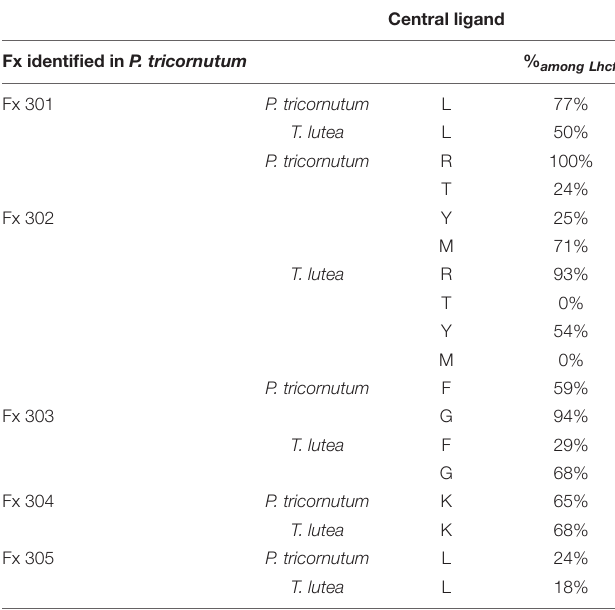
TABLE 3 | Binding sites of Fx amino acid (in capital letters) in T. lutea according to those identified in P. tricornutum (Wang et al., 2019a).